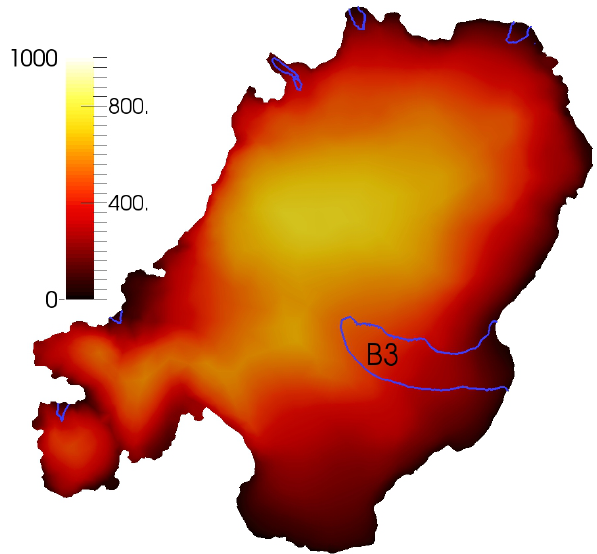
Figure 1. Surface height of the Austfonna ice cap. Fast-flowing out- let glaciers are indicated by the blue 100ma − 1 contour calculated Fig. 1. Surface height of the Austfonna ice cap. Fast flowing out- from 2011 observed velocities. The Basin 3 outlet glacier is labelled let glaciers are indicated by the blue 100 ma − 1 contour calculated B3. North is towards the top of the from 2011 observed velocities. The Basin 3 outlet glacier is labelled B3. North is towards the top of the figure.